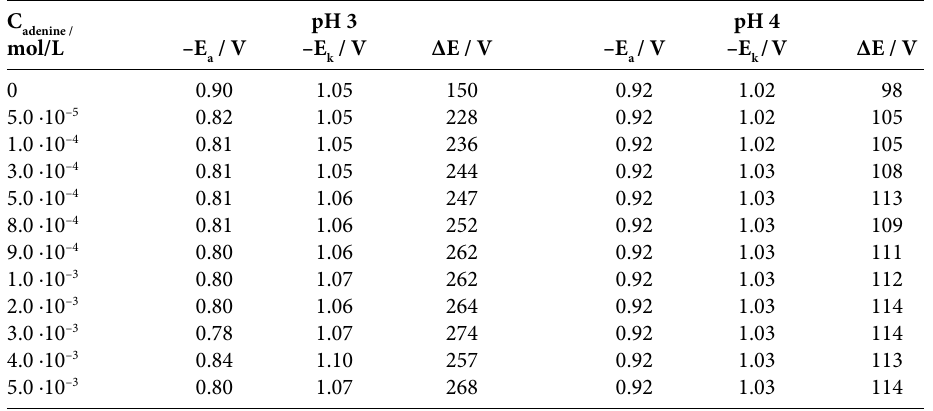
Table 3. Values of potentials anodc and cathodic peaks and their difference for the system: 5 × 10 –3 mol L –1 Zn(II) in the buffer solutions at pH 3 and pH 4 without adenine and for various adenine concentrations.